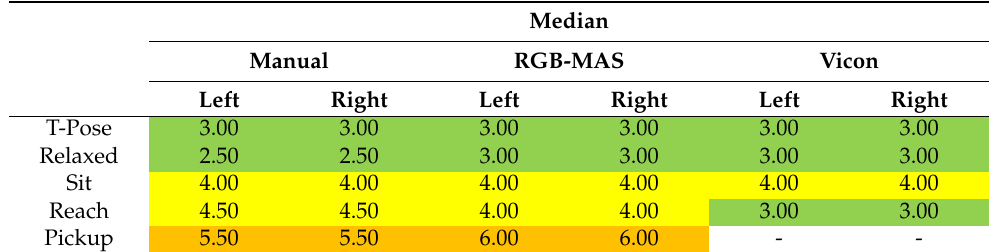
Pickup 5.50 5.50 6.00 - -